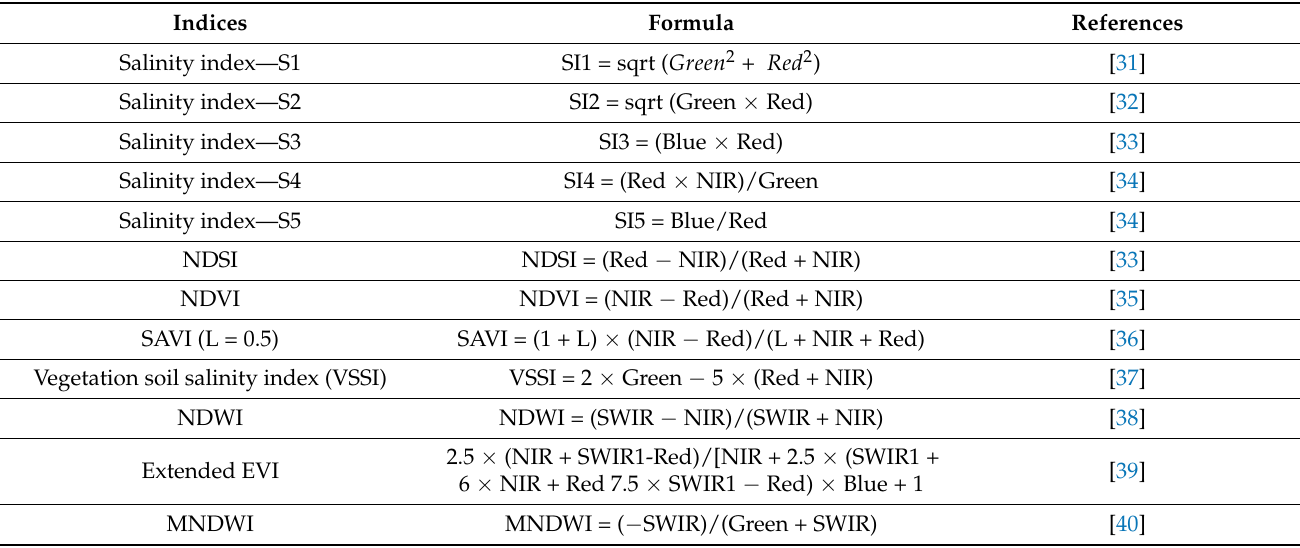
Table 2. Indices used to L8 and S2